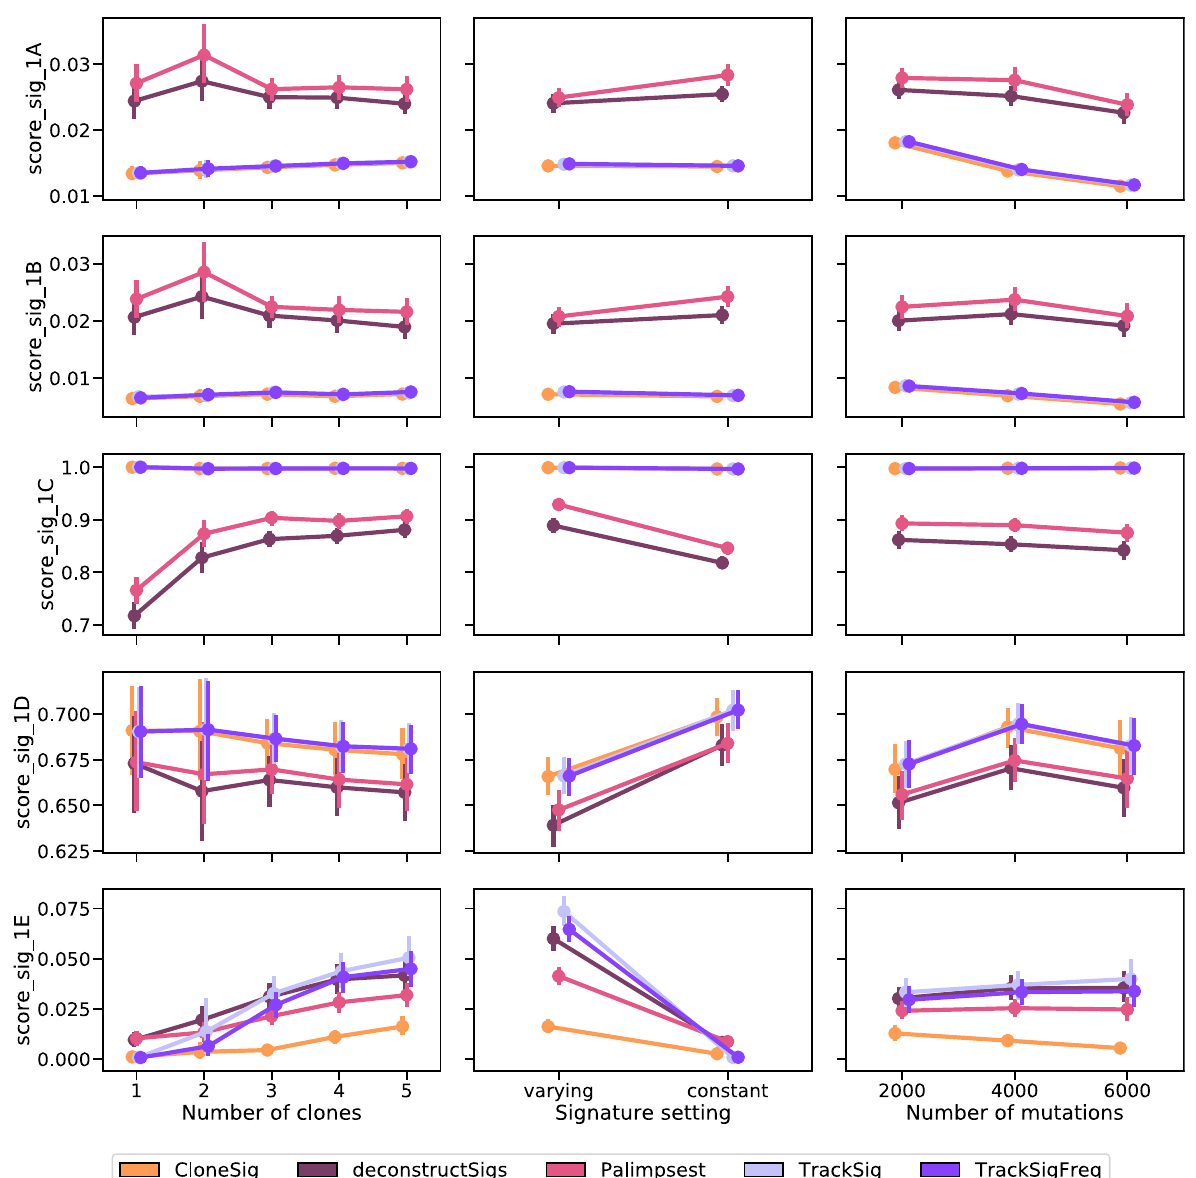
Fig. 5 Comparison of CloneSig, deconstructSigs, Palimpsest, TrackSig, and TrackSigFreq for signature activity deconvolution on the PhylogicSim500 dataset. Several metrics have been implemented, and are detailed in the main text. Scores_sig_1A and 1B are distances between the estimated mutation type pro fi le (as de fi ned by the signature activity proportions) to the true mutation pro fi le (de fi ned using the parameters used for simulations, 1A), and the empirical observed mutation pro fi le (de fi ned using available observed mutations, 1B), and is better when close to 0. Score_sig_1C is the area under the ROC curve for the classi fi cation of signatures as active or inactive in the sample, and is better when close to 1. Score_sig_1D is the proportion of mutations for which the correct signature was attributed, and is better when close to 1. Finally, Score_sig_1E is the median distance to the true mutation type pro fi le of the clone to which a mutation was attributed from the true distribution of its original clone in the simulation, and is better when close to 0. The results are presented depending on several relevant covariates: the true number of clones (left), the signature activity setting (middle), and the number of mutations (right). Each point represents the average of the score over all available simulated samples. We used bootstrap sampling of the scores to compute 95% con fi dence intervals. There are respectively 87, 47, 223, 250, and 236 samples with 1, 2, 3, 4, and 5 clones, 428 samples with constant and 415 with varying signature activities between clones, and 267, 347, and 229 samples with approximately 2000, 4000 and 6000 observed point mutations. Source data are provided as a Source Data fi